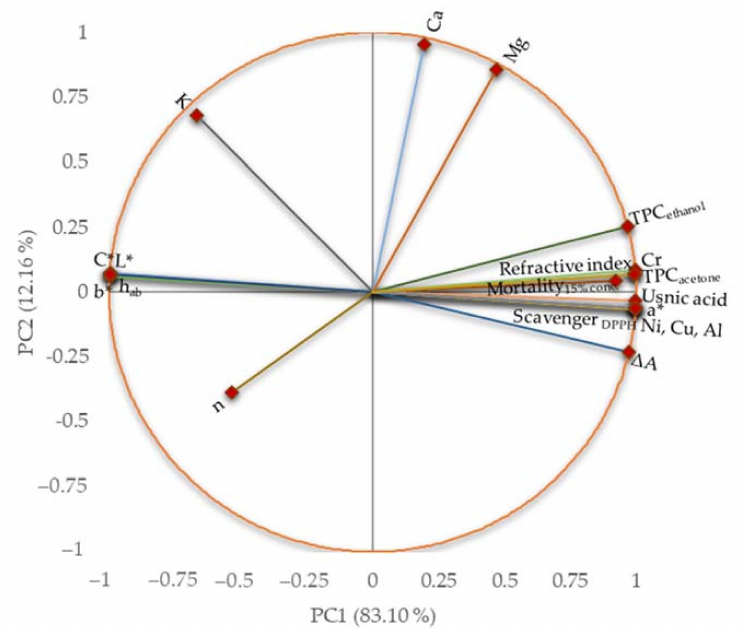
Figure 11. Principal component analysis (PCA) plot for UBO and CNO characteristics: L*